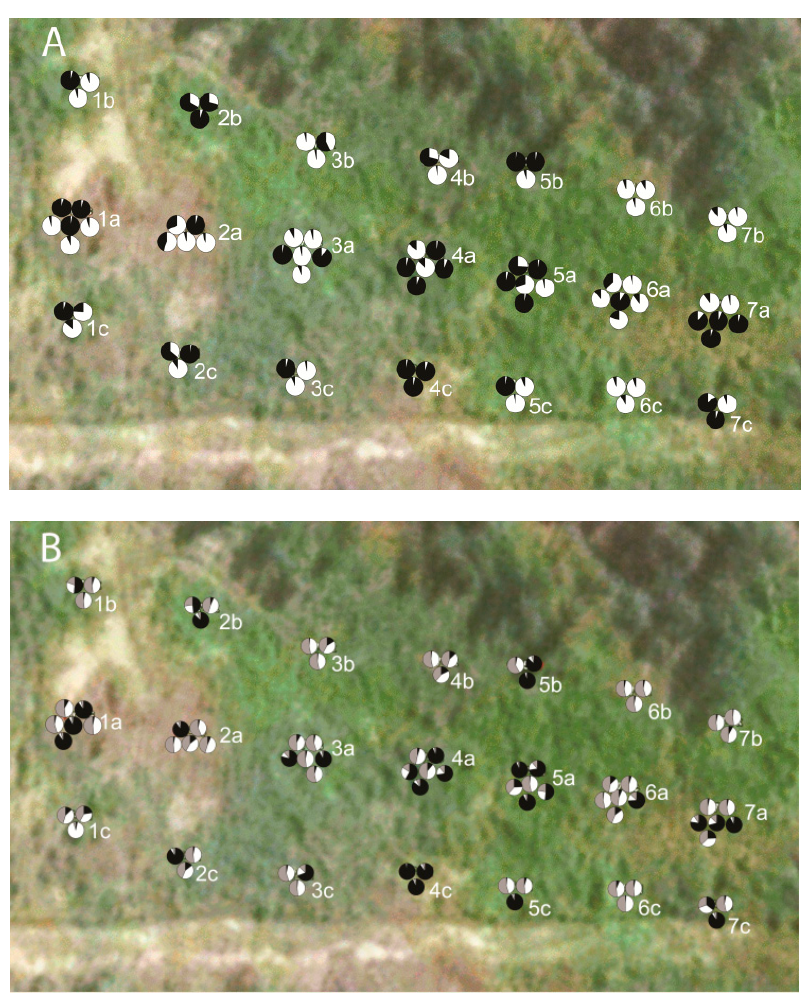
Figure 6. Spatial distribution map of sampled Norway spruce ( Picea abies (L.) H. Karst) juveniles regenerating in a clear-cut site of a windthrown spruce stand (see Figure 2 for more information). Circles show STRUCTURE groups of individual juveniles as assigned to two ( A ) and three ( B ) most likely genetic clusters.